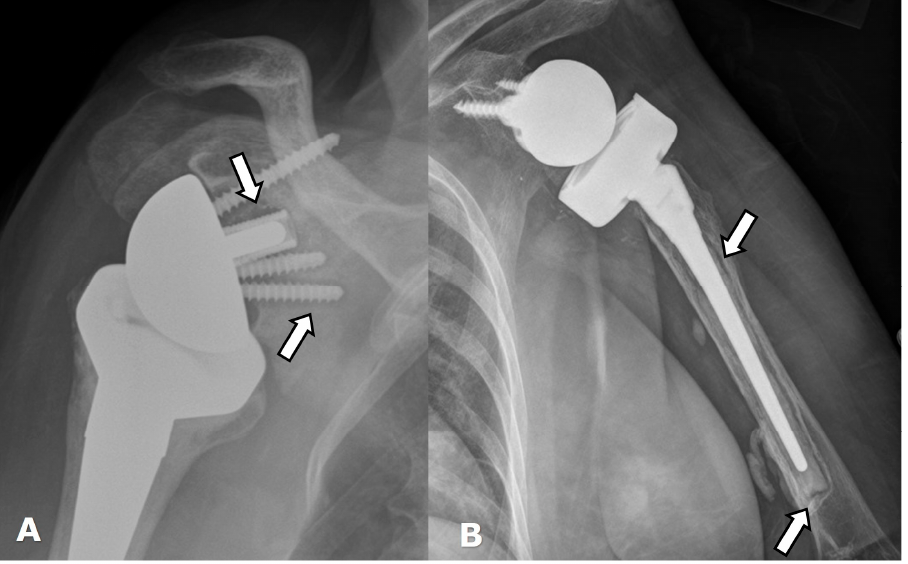
Figure 15. ( A ) Frontal radiograph in a patient with an RTSA shows lucency (arrows) along the baseplate screws and central screw consistent with loosening. ( B ). Frontal radiograph in a different patient with RTSA shows lucency (arrows) around the humeral component as well as the bone– cement interface, consistent with loosening. Cortical thinning is also noted along the medial aspect of the distal humeral stem.